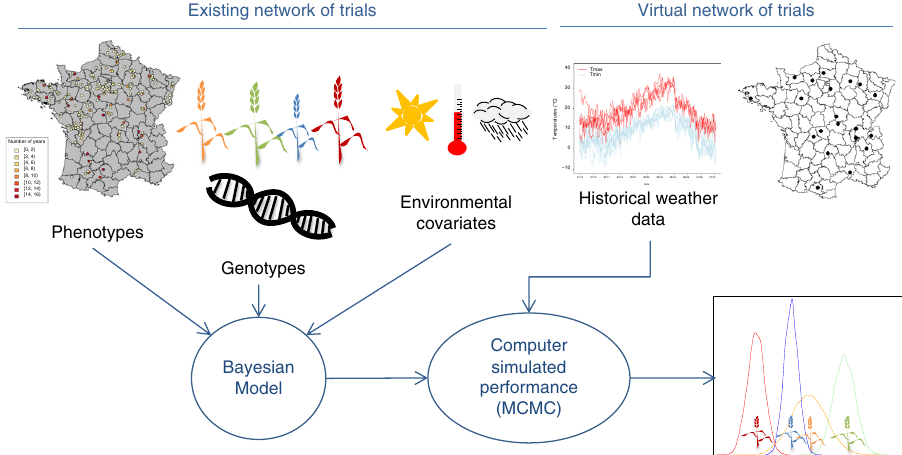
Fig. 1 Computer-simulated performance of candidate genotypes in target locations. The proposed computer-simulation platform uses phenotype, genotype (e.g., SNPs), and environmental covariate data collected in an existing network of trials and historical weather records at target locations ( “ virtual network of trials ” ) to simulate the performances of selected genotypes in target locations, under possible weather